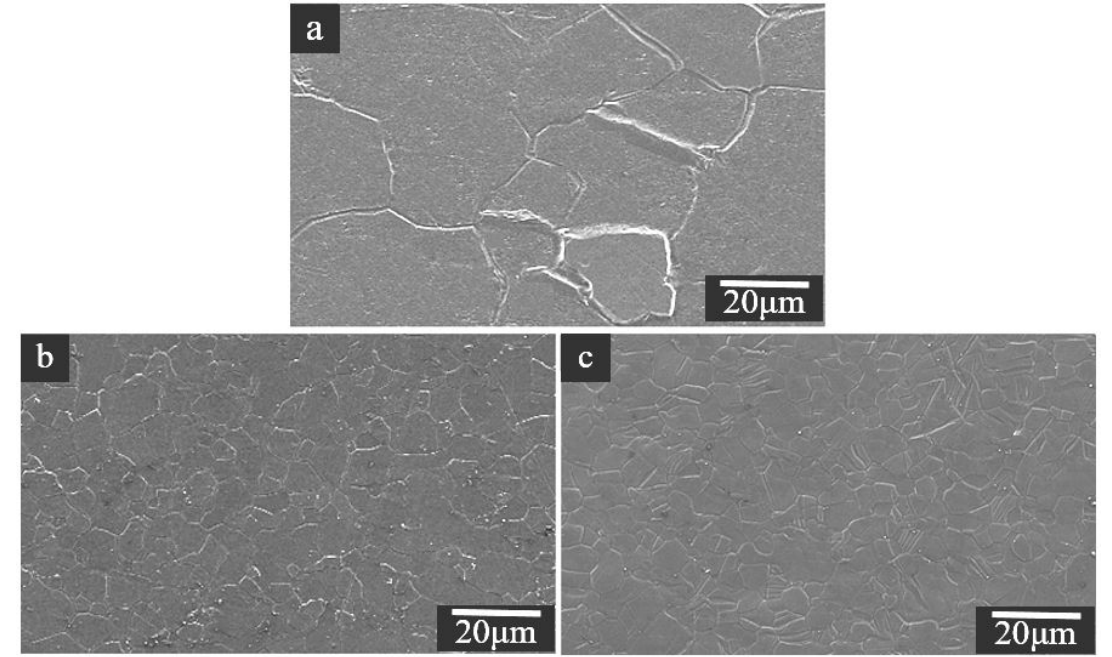
Figure 3. SEM images obtained using the Secondary Electron (SE) signal for pure Mg after processing by: (a) ECAP; (b) ECAP+CR; (c)